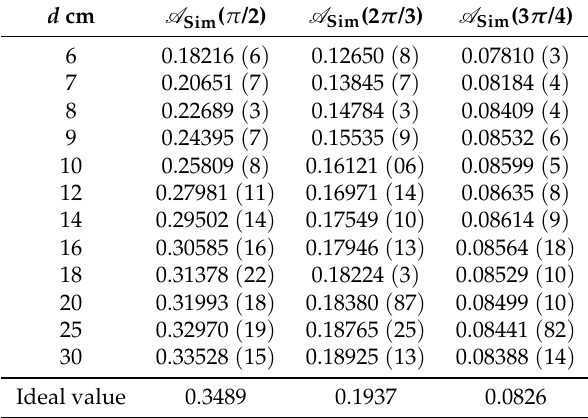
Table 1. A comparison among A Sim ( π /2 ) , A Sim ( 2 π /3 ) , and A Sim ( 3 π /4 ) for the spin sequence 5 → 9 → 5 as affected by the target-to-detector distance d . The other parameters are fixed such that 2 2 2 R d = 60 mm, λ t = 10 mm, and R t = 10 mm. Numbers in parentheses are the uncertainties referred in the least significant